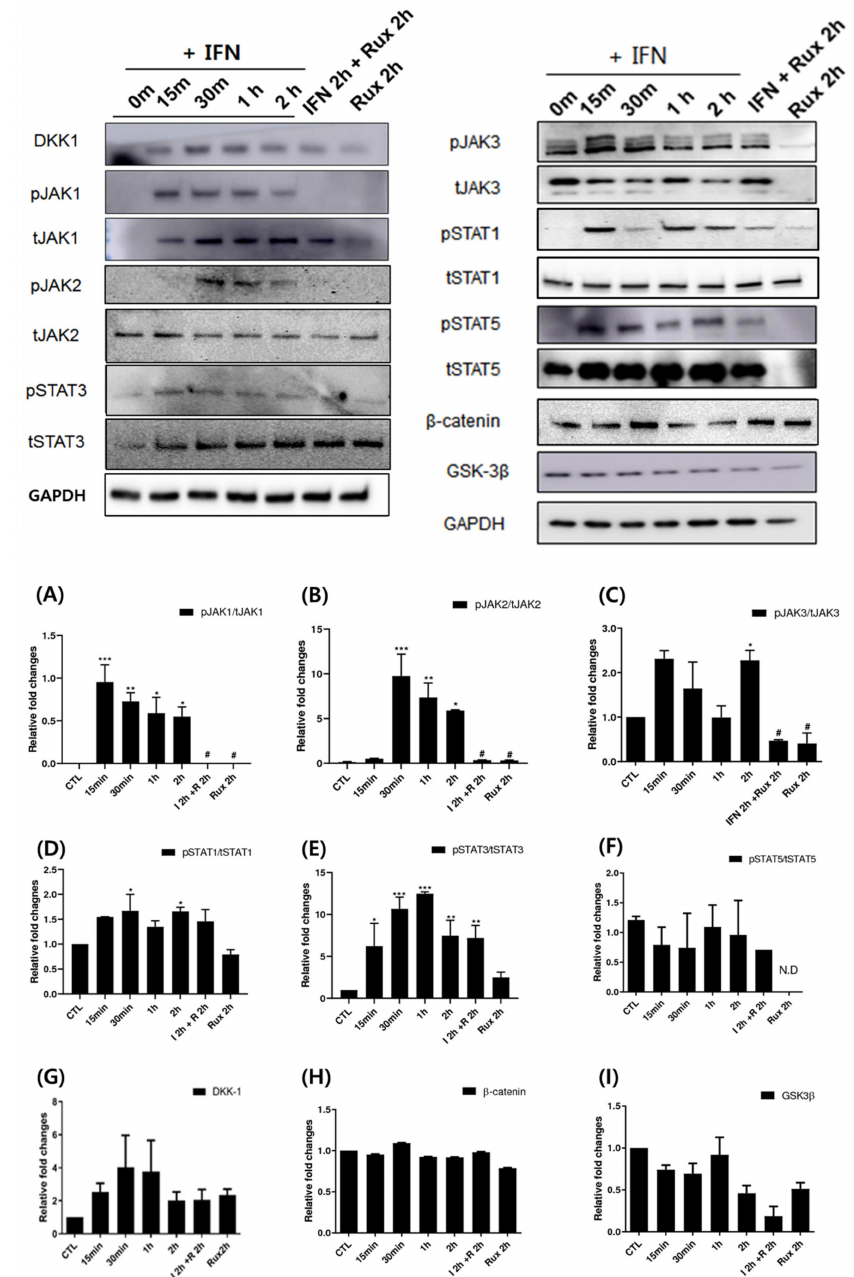
Figure 3. Changes in Janus kinase (JAK)-signal transducers and activators of transcription protein (STAT) pathway-related molecules after treatment with ruxolitinib. Western blotting showed changes in the levels of phosphorylated ( A ) JAK1, ( B ) JAK2, and ( C ) JAK3, ( D ) STAT1, ( E ) STAT3, and ( F ) STAT5, and ( G ) DKK1, ( H ) β -catenin, and ( I ) GSK-3 β . The bands indicate serial protein expression levels up to 2 h after ruxolitinib treatment. The data represent the means ± SEM, n = 4, statistically significant at * p < 0.05, ** p < 0.01, *** p < 0.001 compared to control and # p < 0.05 compared with the IFN- γ -2 h treated